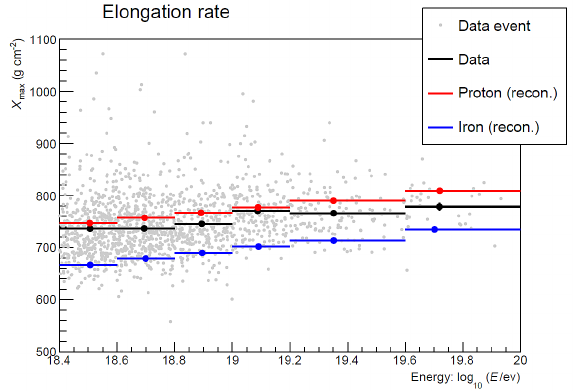
Figure 2: Preliminary nine year TA stereo (cid:104) X max (cid:105) com- pared to QGSJET II-03 expectation. The observed data is consistent with light